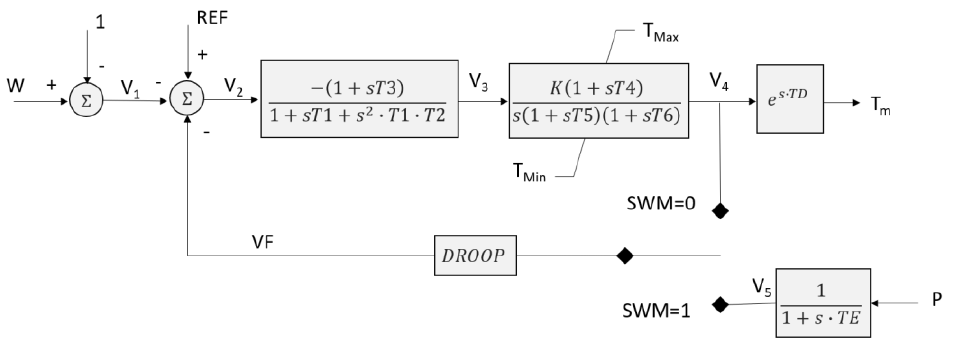
Figure A6. Diesel turbine governor (adopted by [57]).